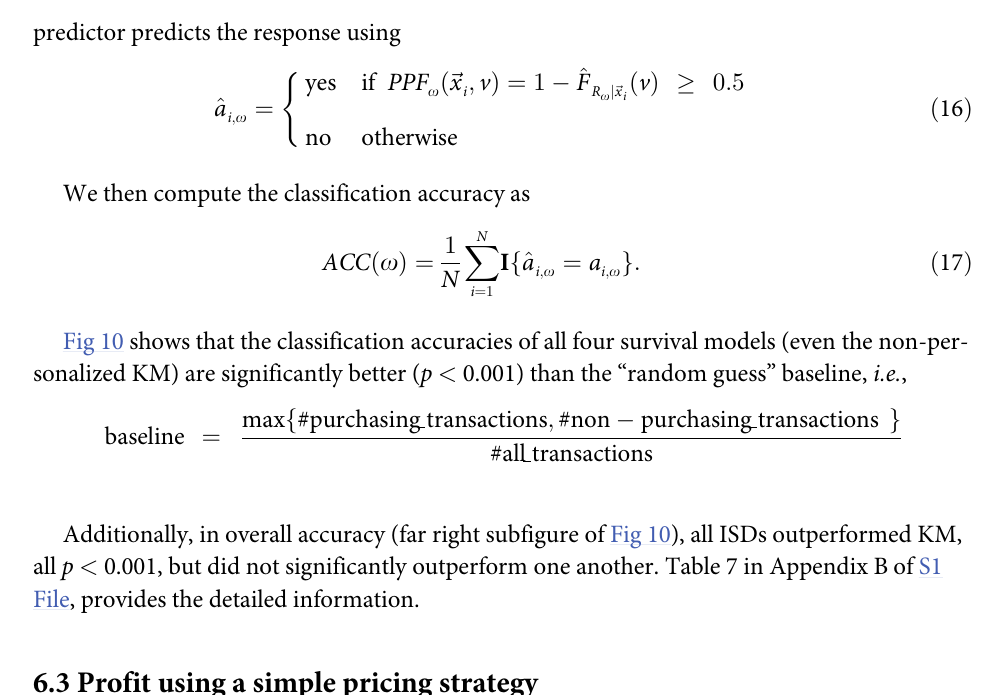
PLOS ONE | https://doi.org/10.1371/journal.pone.0249182 April 29,